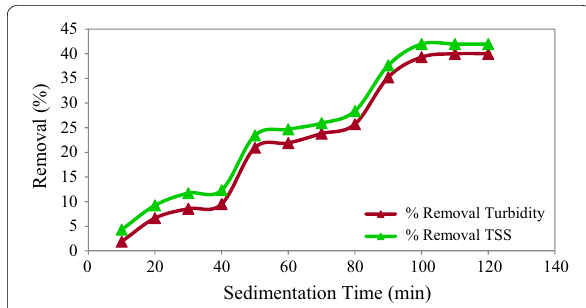
Fig. 2 The effect of sedimentation time, before of coagulation process on removal turbidity and